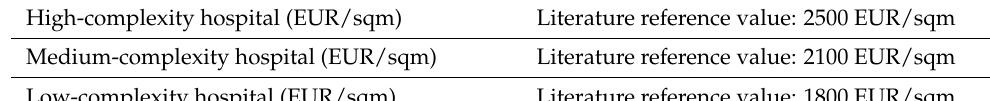
Table A3. Building box mono-parametric construction costs. In this section, the 3 different hospital complexity typologies (HUB, SPOKE, BASE) are reported, and it is required to insert a value in EUR/sqm and EUR/bed for their construction.